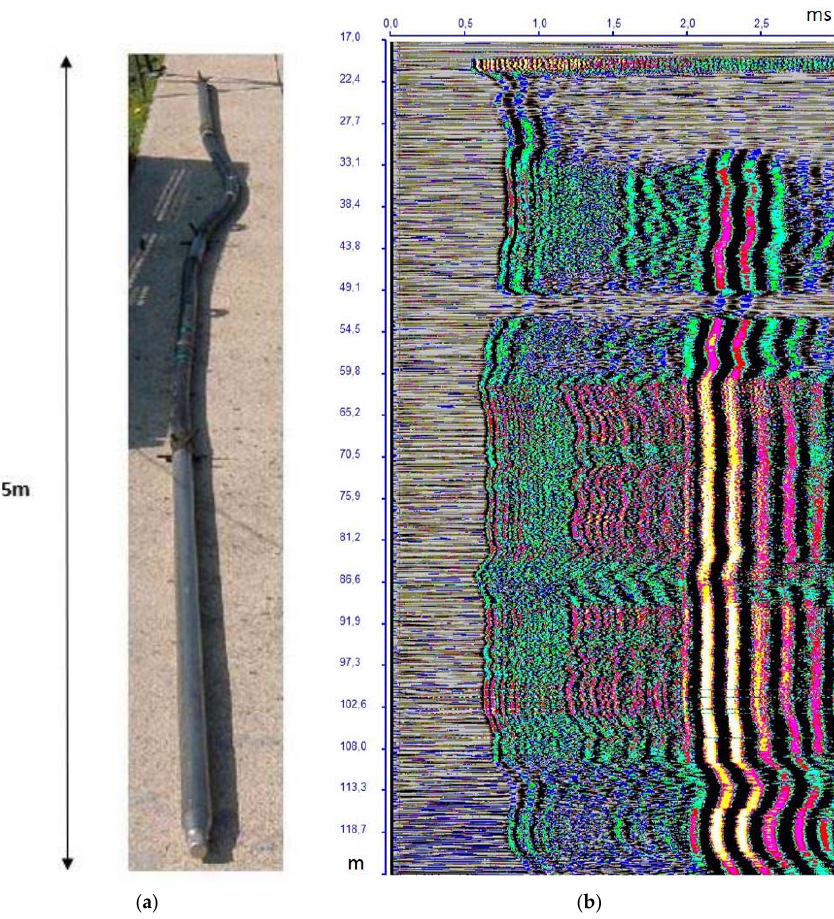
Figure 7. Full wave acoustic logging: ( a ) tool, ( b ) acoustic section (vertical axis: depth in m, horizontal axis: time in ms). Water 2020 , 12 , x FOR PEER REVIEW